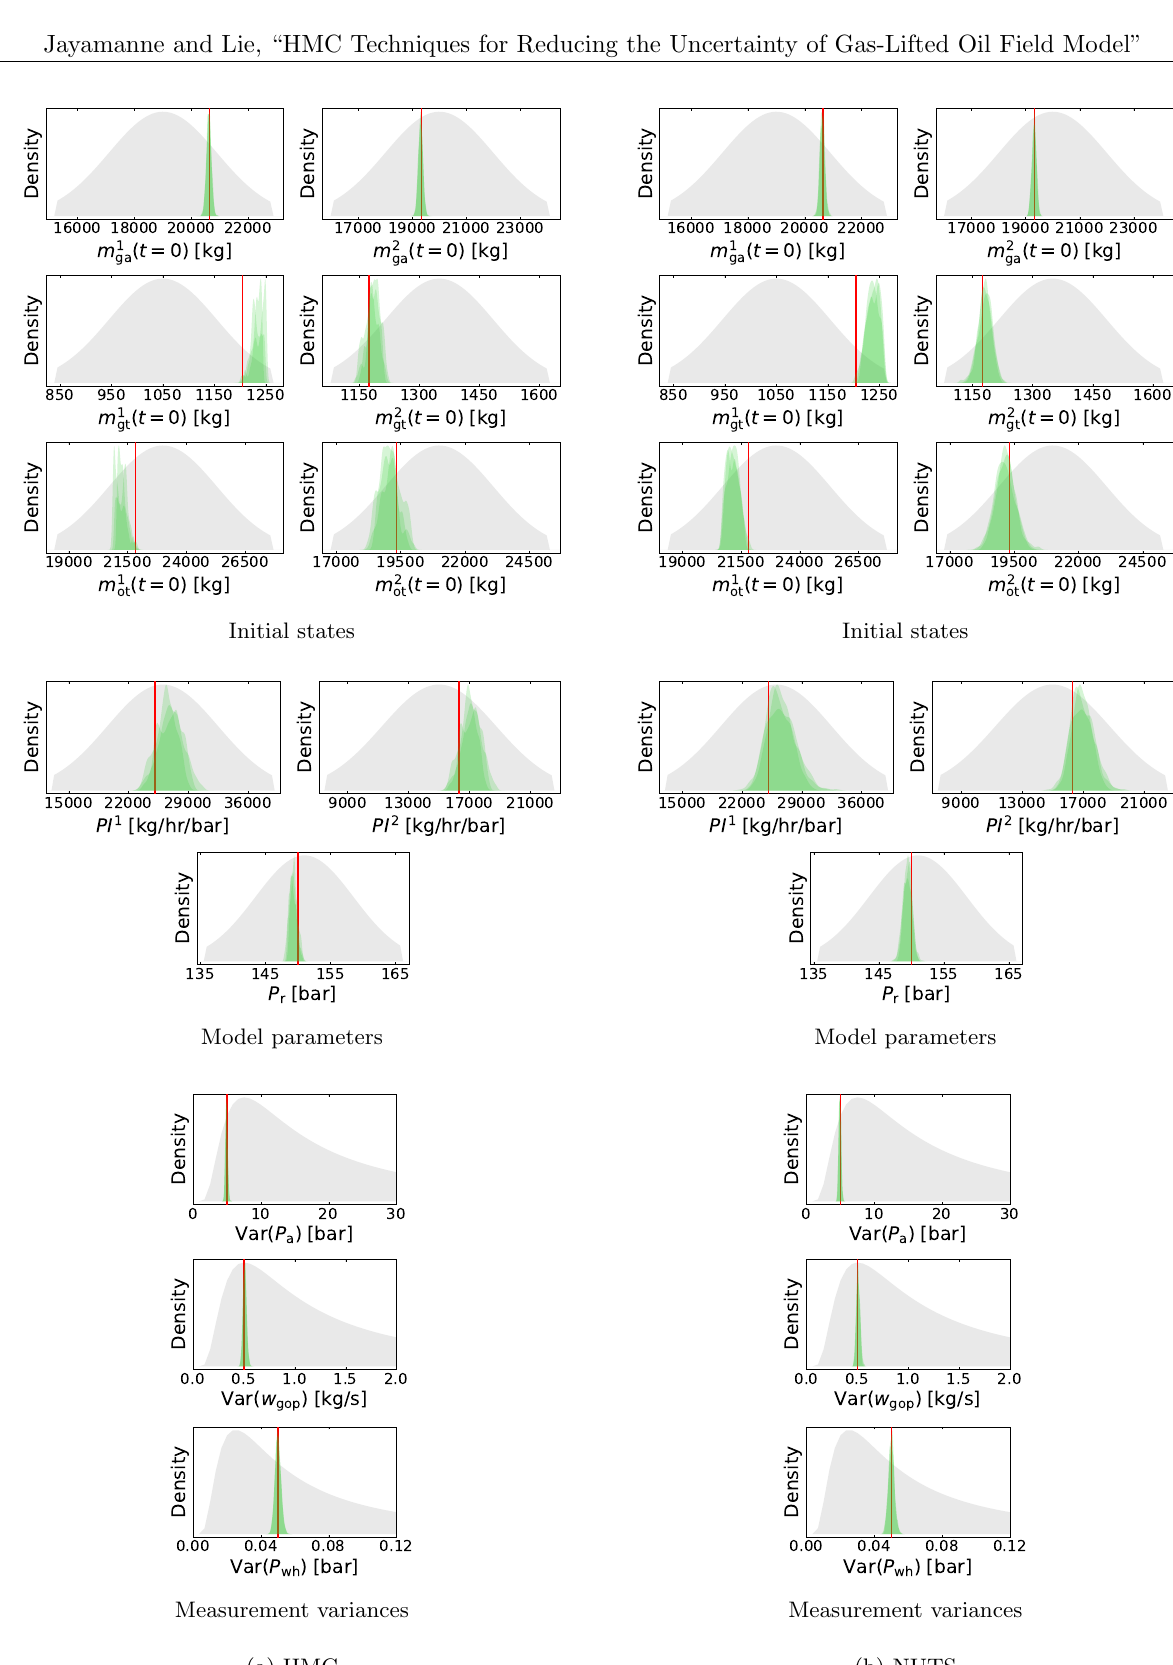
Figure 6: Prior PDFs (grey) vs. posterior PDFs (green) vs. actual values